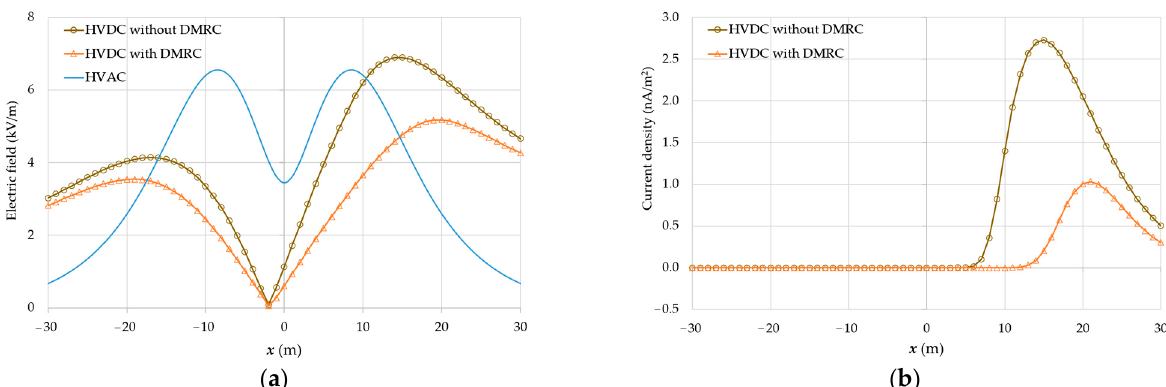
Figure 10. Electric field magnitude and ion current density at the ground level of the ±500 kV configuration under the annually average wind condition: ( a ) electric field magnitude; ( b ) ion current density.